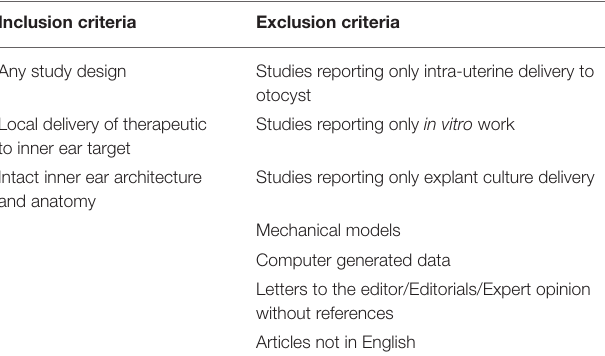
TABLE 1 | Inclusion and exclusion